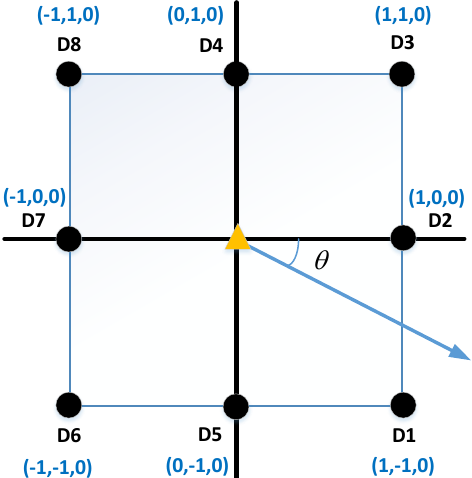
Figure 1. Placement of different dose rate monitors (distance in